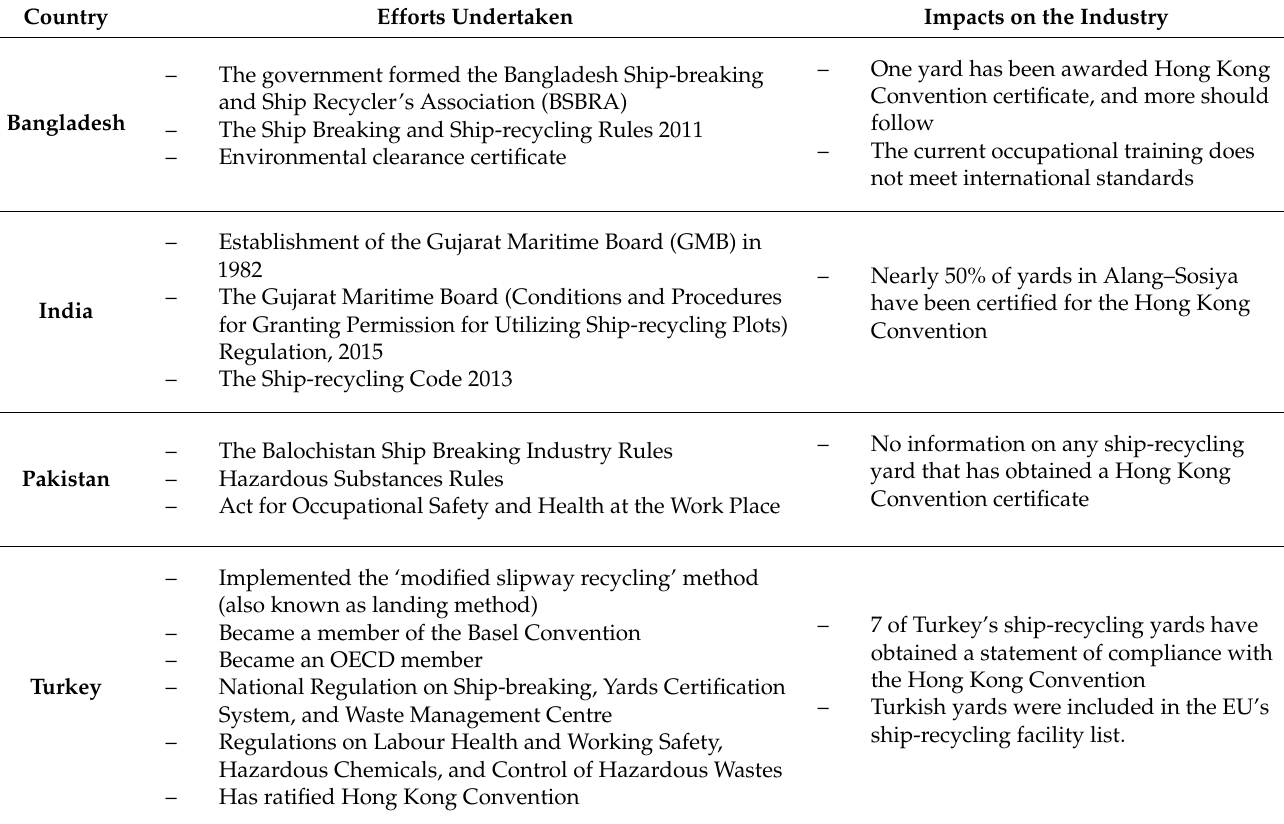
Table 1. Lessons learned from reviewing literature on world-leading ship-recycling